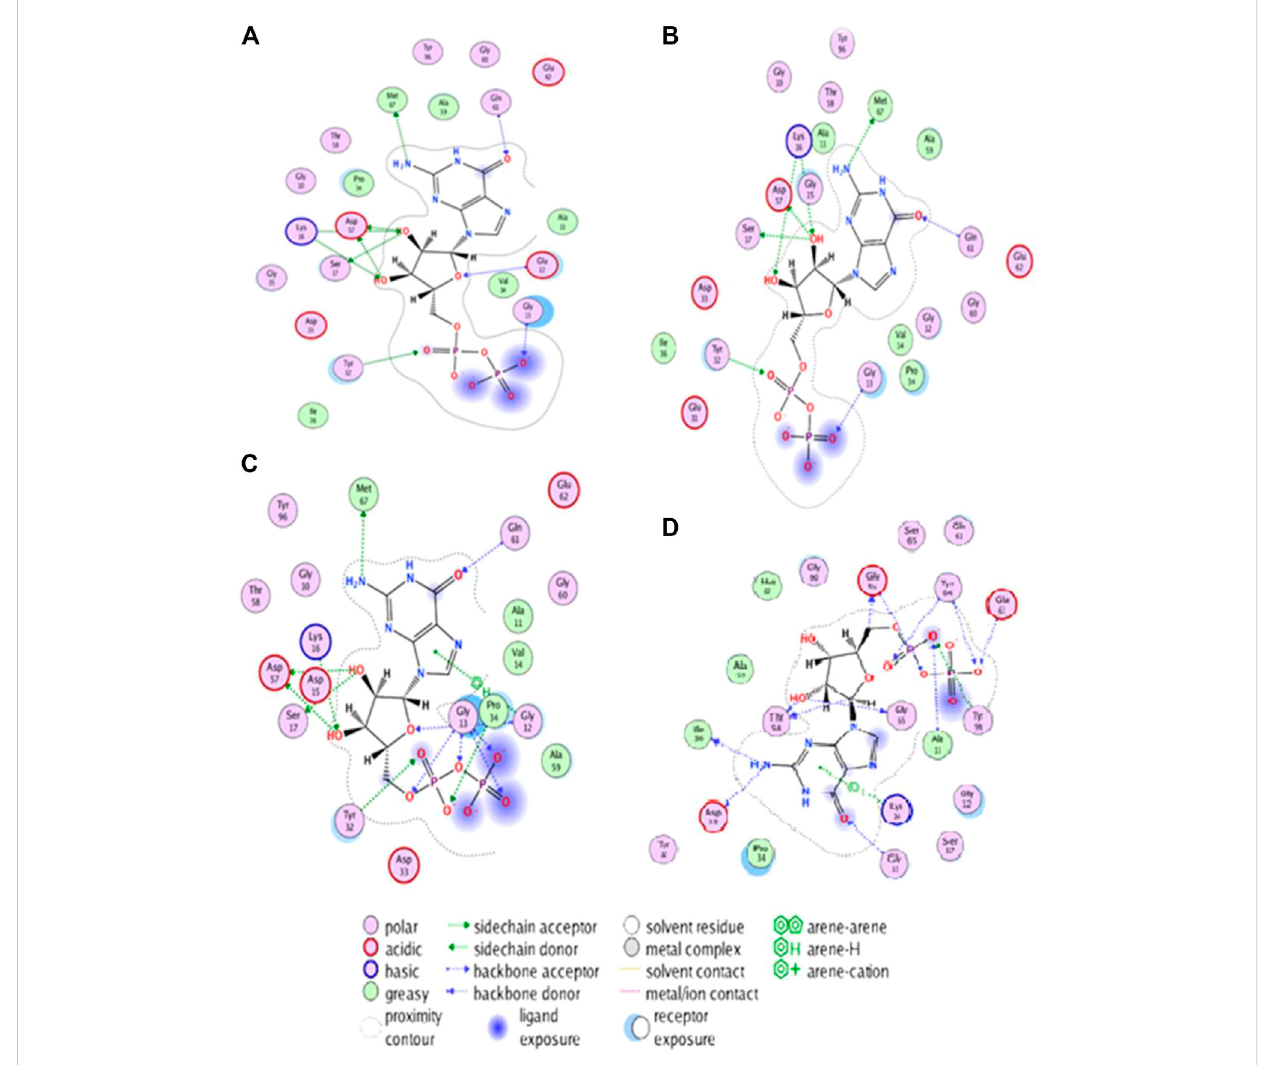
FIGURE 5 Visualizing structural changes in active site of HRAS protein due to mutations: Insights from hydrogen bonding and hydrophobic interactions.